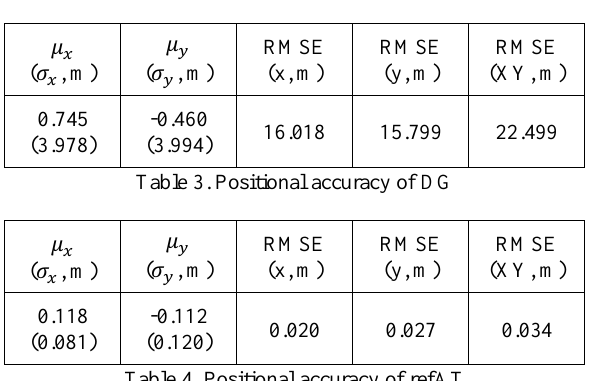
Figure 9. Seamlines between individual orthoimages